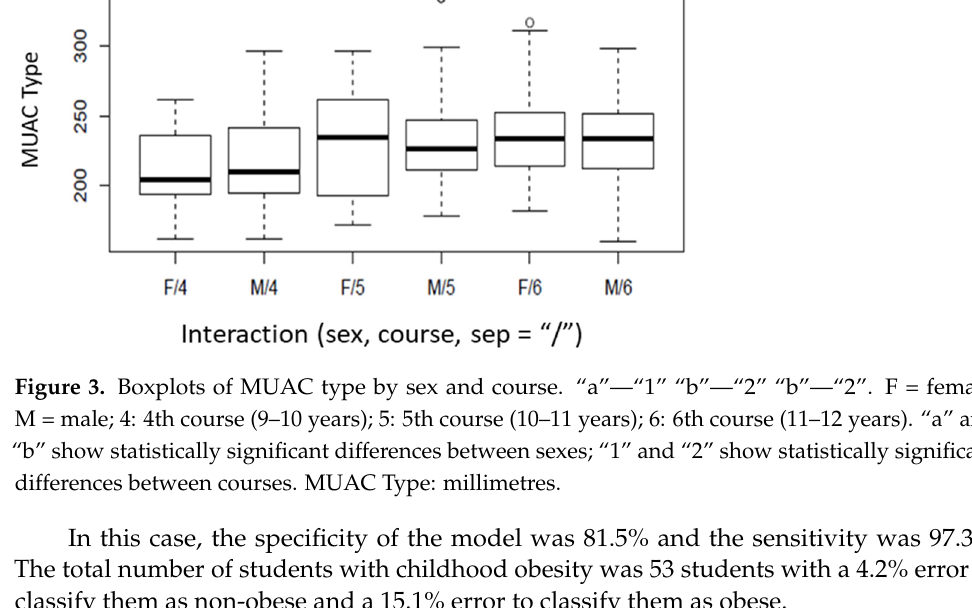
Figure 3. Boxplots of MUAC type by sex and course. “a” — “1” “b” — “2” “b” — “2”. F = female; M = male; 4: 4th course (9 – 10 years); 5: 5th course (10 – 11 years); 6: 6th course (11 – 12 years). “a” and “b” show statistically significant differences between sexes; “1” and “2” show statistically significant differences between courses. MUAC Type: millimetres.